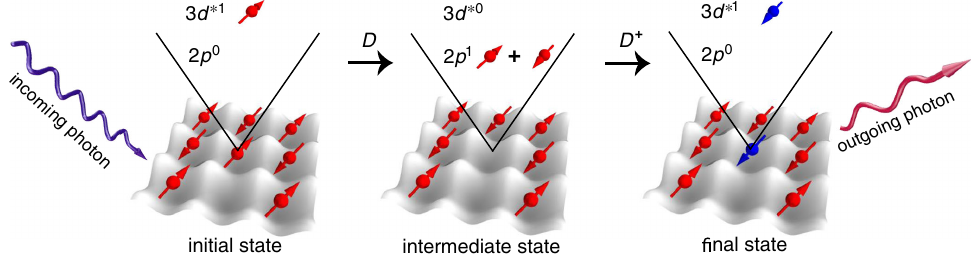
FIG. 9. A cartoon picture of the dominant Cu L -edge RIXS process in the cross-polarized “ channel. ”